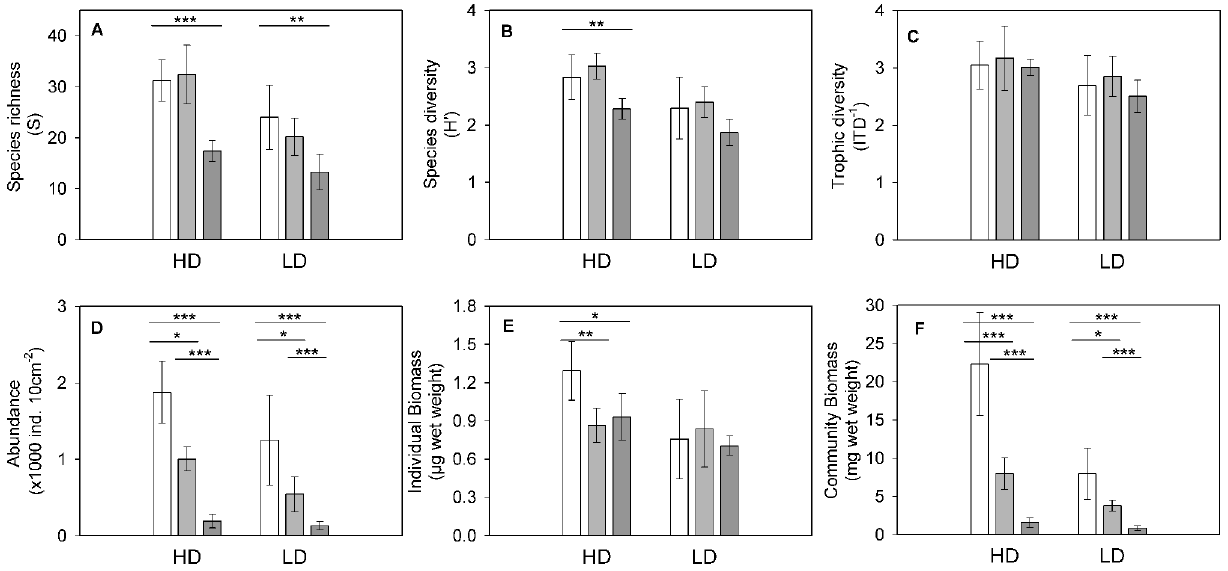
Figure 5. Comparison of the experimental assemblages. Mean ( 6 standard deviation) of A: Species richness ( S ), B: Diversity ( H’ ; Index of Shannon Wiener), C: Abundance (individuals per 10 cm 2 2 ), D: Trophic diversity ( IDT 2 1 ), E: Individual biomass (in m g wet weight), and F: Community biomass (in mg wet weight). HD = High diversity, LD = Low diversity. White bars = time 0 controls, light gray bars = control temperature (31 u C), dark gray bars = high temperature (36 u C). Asterisks indicate significance levels after multiple comparisons with Dunnett test between xDt 0 and xD 31 and xD 36 respectively. Significance between xD 31 and xD 36 were assessed with Student’s t-tests. * , 0.05, ** , 0.01, *** , 0.001.